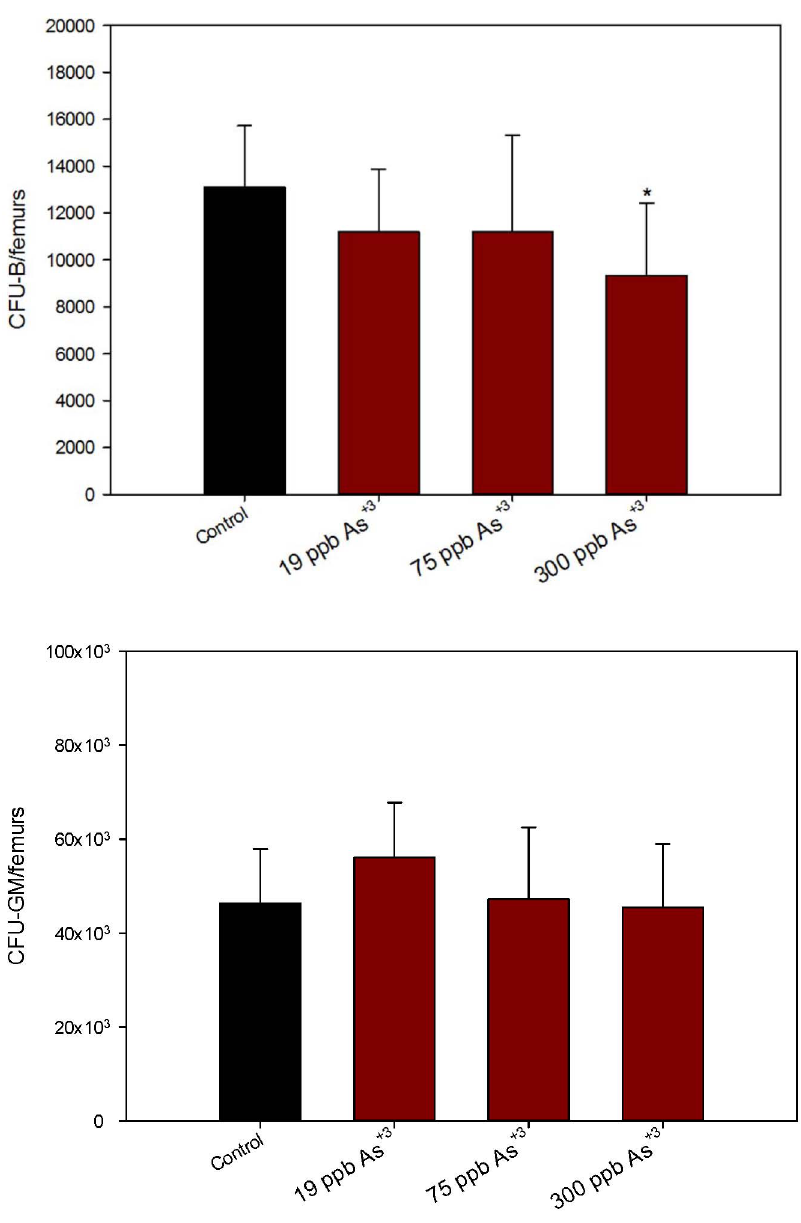
Figure 3. Invivo BM exposure to As + 3 showing number of colonies per pair of mice femurs. Number of CFU-B colonies in a pair of mice femurs, 10 days post plating in mouse methylcellulose media for pre-B [Top]. Number of CFU-GM colonies in a pair of mice femurs 14 days post plating in Methocult media for GM selection [Bottom] after 30 day consumption of As + 3 via drinking water. *Significantly different compared to control (p , 0.05). Results are Means +